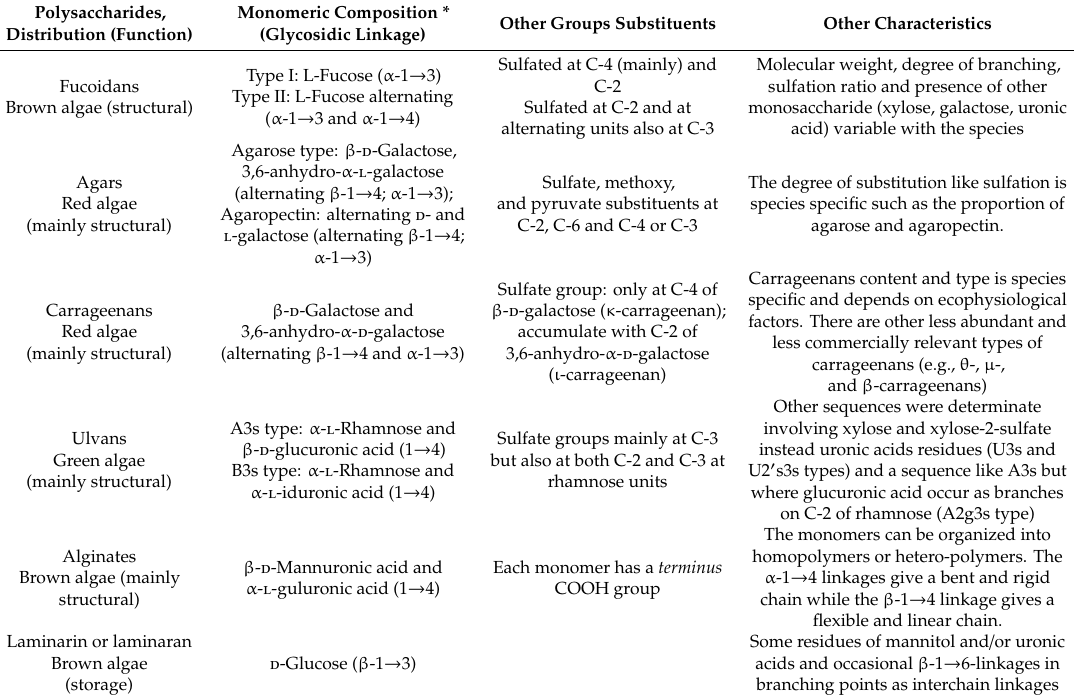
Table 2. Chemical composition and structural features of polysaccharides from